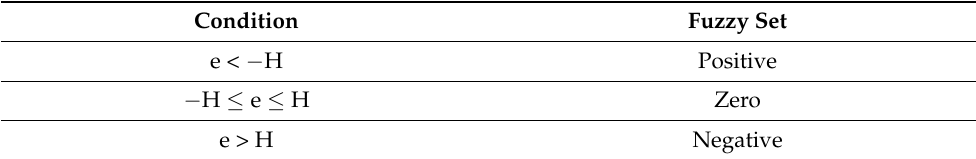
Figure 7. Internal structure of fuzzy controller. Table 1. Fuzzy sets are divided according to the relationship between e and H .